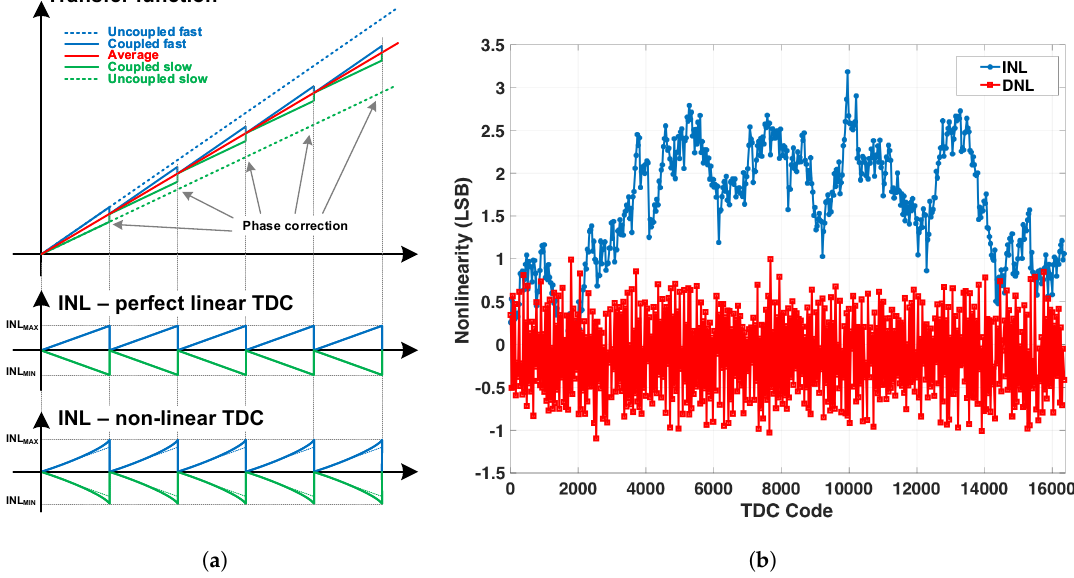
Figure 18. TDC non-linearity effects: ( a ) Local INL due to phase correction, for a perfect linear TDC and a non-linear TDC; ( b ) Uncoupled TDC INL and DNL, without calibration. The phase noise is a key parameter to confirm the effectiveness of mutual coupling on noise filtering and synchronization. Figure 19 shows an 18 dB phase improvement provided by the coupling, for most of the frequency offsets, following the theory. For high-frequency offsets, the coupling elements’ thermal noise dominated the phase noise, and due to its correlation within the array, the coupling was not as effective.